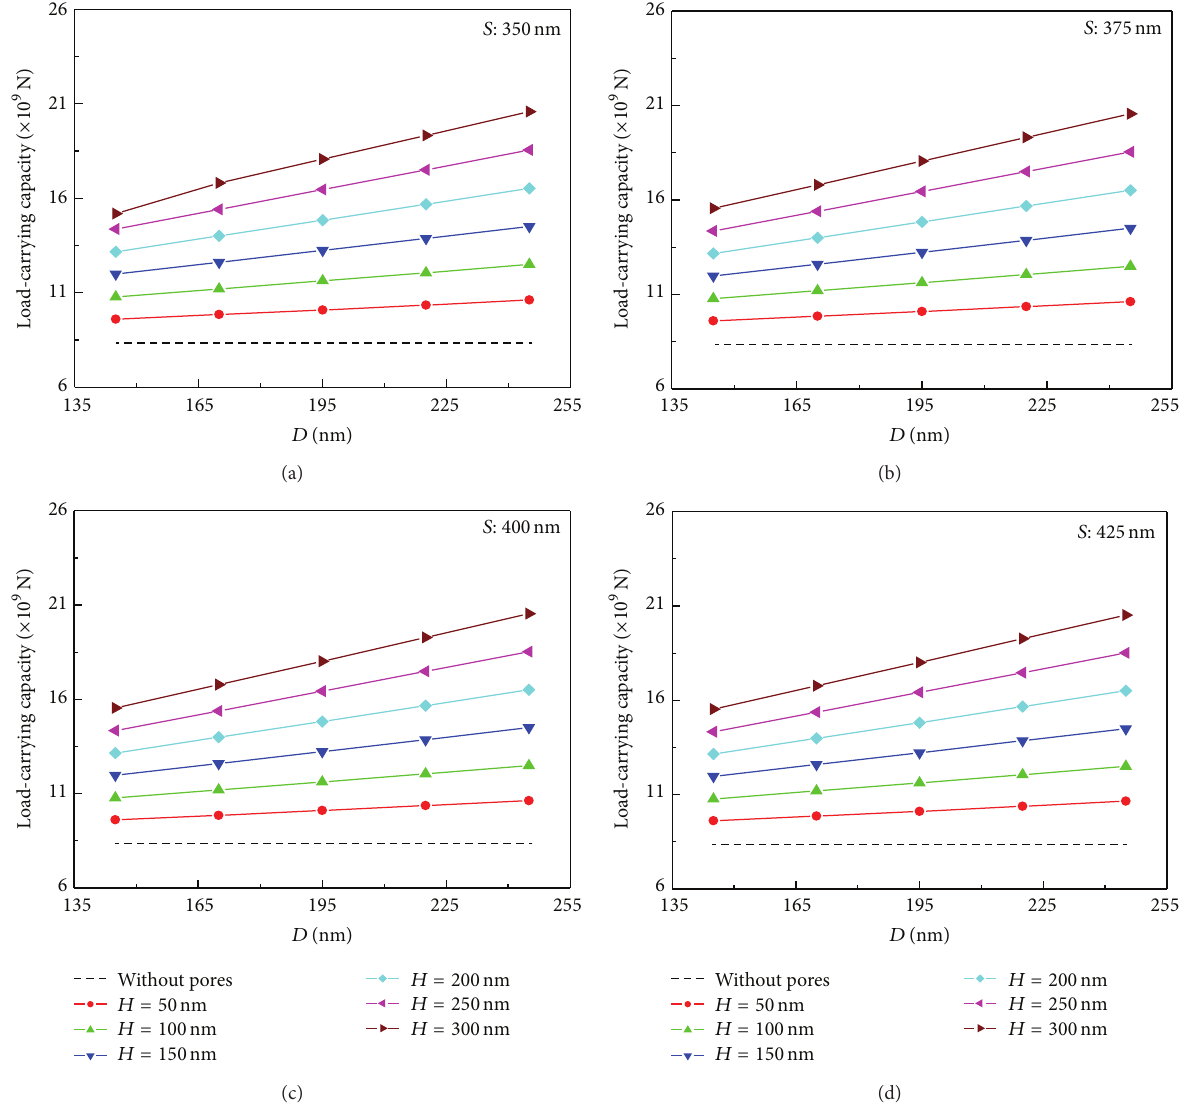
Figure 3: Load-carrying capacities at different pore diameters and depths of Coscinodiscus sp.: (a) at interval of 350 nm, (b) at interval of 375 nm, (c) at interval of 400 nm, and (d) at interval of 425 nm.